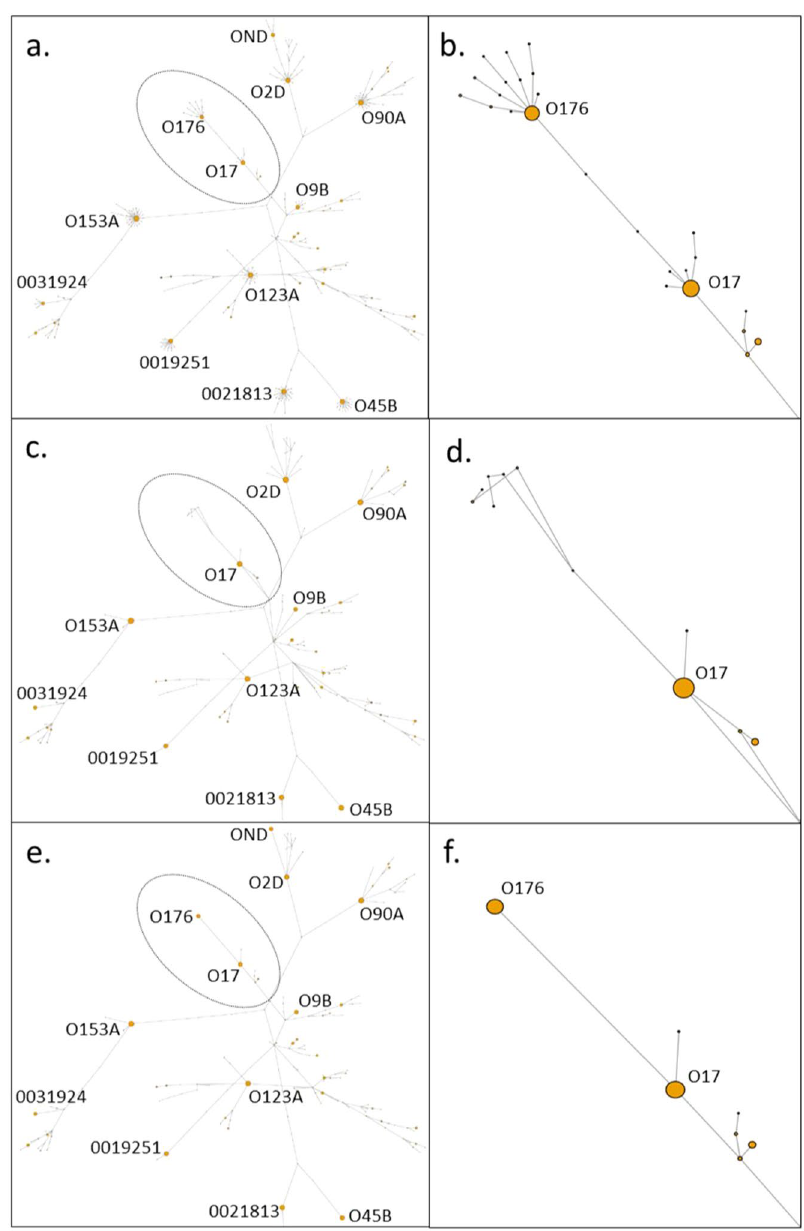
Figure 2. Effect of clustering using CD-HIT and EC model on relative abundance and total number of gSTs. To illustrate the discordance between clustering and statistical modelling methods in determining the genetic diversity and abundances of all 348 gSTs generated from the P = 0.015 dataset, a minimum spanning tree was generated with highly abundant gST ( > 4000 reads) nodes labelled. Node size indicates relative abundance of gST reads in the P = 0.015 dataset. ( a) Unadjusted minimum spanning tree of all 348 gSTs generated from the P = 0.015 dataset with branch containing O17 (9432 reads) and O176 (6527 reads) gST nodes that differ by a one SNP, labelled with dotted black oval. ( b ) Enlarged branch of unadjusted minimum spanning tree containing O17/O176 gST nodes, illustrating low abundance daughter gSTs (smaller nodes) that differ from O17 and O176 nodes by one SNP. ( c ) Minimum spanning tree of gSTs generated from the P = 0.015 dataset clustered at 99.6% similarity level (one SNP) using CD-HIT. Branch containing O17 gST (16132 reads) labelled with dotted black oval. ( d ) Enlarged branch of minimum spanning tree containing O17 gST node, illustrating the absence of the O176 gST node having been clustered with with O17 gST due to 99.6% similarity (one SNP). ( e ) Minimum spanning tree of gSTs generated from the P = 0.015 dataset following application of the EC model with branch containing O17/O176 gST nodes that differ by a one SNP, labelled with dotted black oval. ( f ) Enlarged branch of minimum spanning tree containing O17 (9610 reads) and O176 (6536 reads) gST nodes, illustrating the absence of low abundance daughter gST nodes through clustering with highly abundant O17 and O176 nodes. O176 gST node not clustered with O17 gST node using EC model despite 99.6% similarity (one SNP difference) as highly